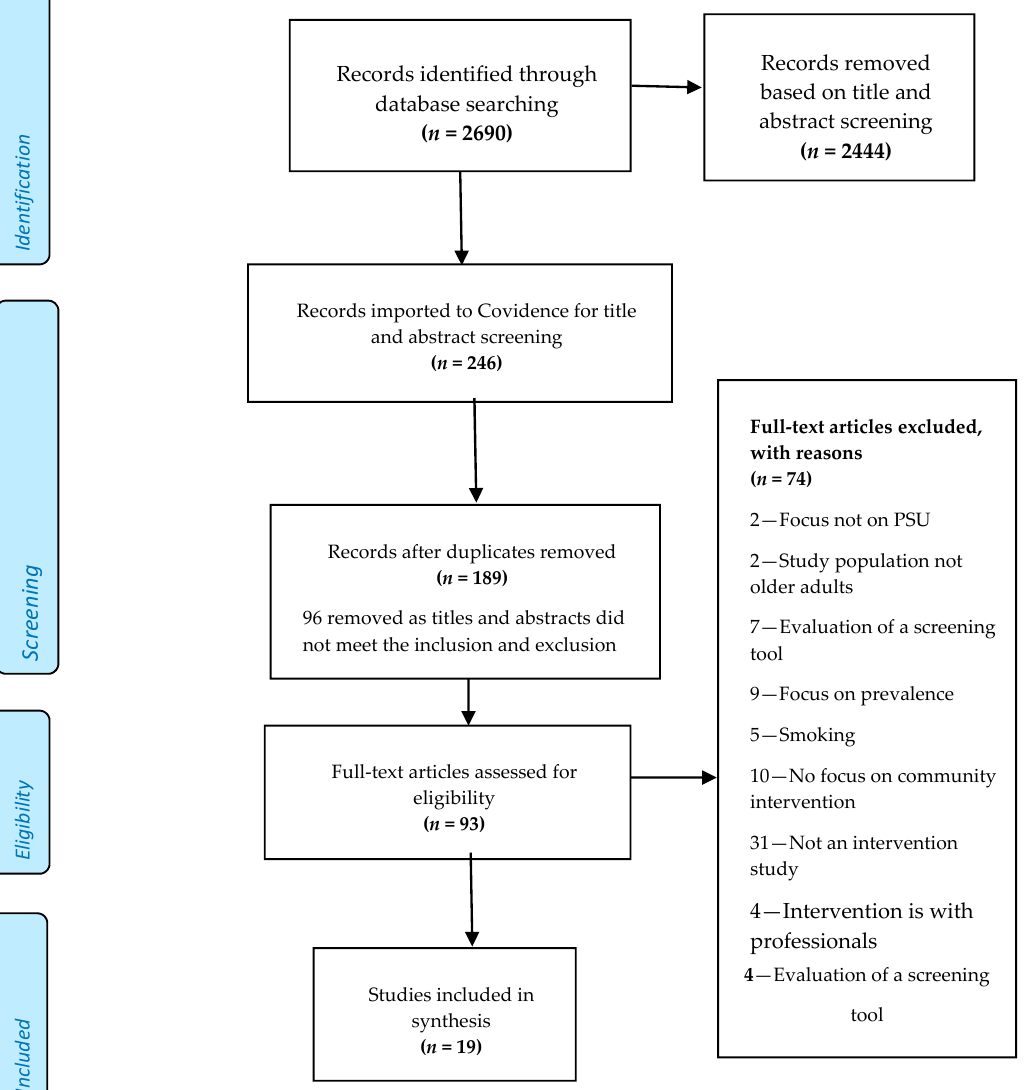
Figure 1. PRISMA flow